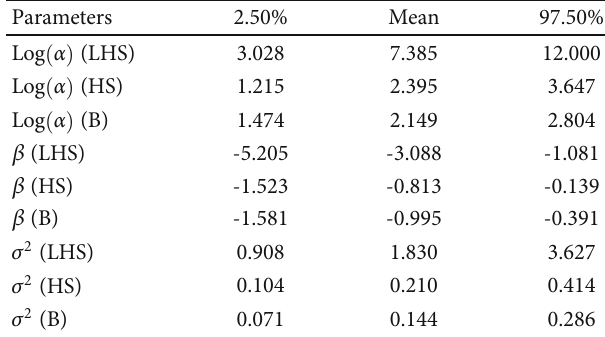
Table 1: 95% HPDIs.